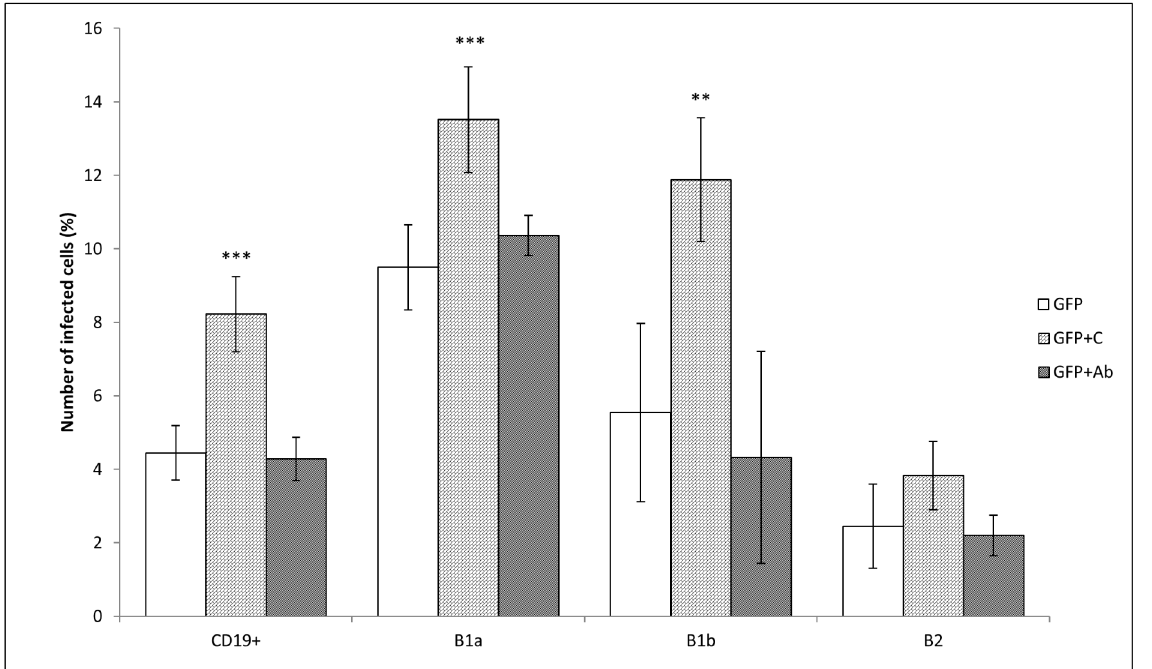
Fig 3. F . tularensis infecting subsets of B cells in vitro . Subsets of B cells were infected for 3 h with unopsonized F . tularensis LVS/GFP (GFP), F . tularensis LVS/GFP opsonized with fresh un-inactivated serum (GFP+C) from na ï ve mice, and bacteria opsonized with heat-inactivated immune sera (GFP+Ab). The proportions of infected CD19 + cells from all measured cells and of infected B-1a, B-1b, and B-2 cells from CD19 + cells were measured by flow cytometry. Error bars indicate SD around the means of samples processed in triplicate. Two-tailed t -test was used to test for significant differences between GFP and GFP+C and GFP+Ab ( *** P < 0.001, ** P < 0.01, * P < 0.05). Results shown from one experiment are representative of three independent experiments.